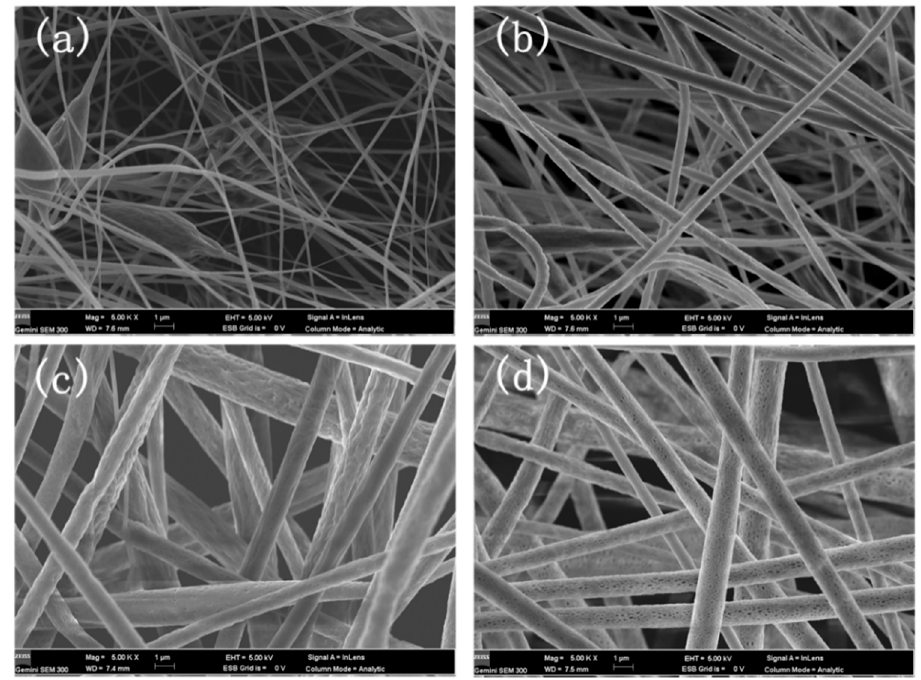
Figure 2. SEM micrographs of PLA fiber membranes with different concentrations: ( a ) 5 wt%, ( b ) 6 wt%, ( c ) 7 wt%, ( d ) 8 wt%.